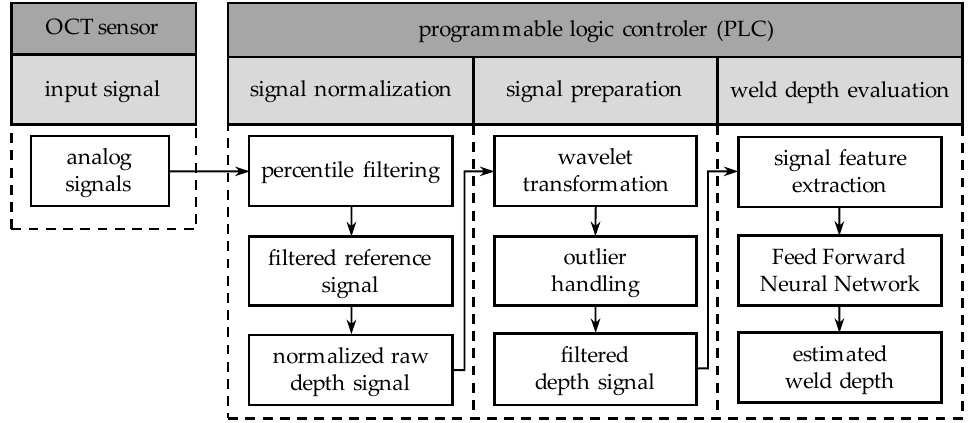
Figure 3. Sequence and data processing steps for the weld depth interpretation based on the analog OCT signals.